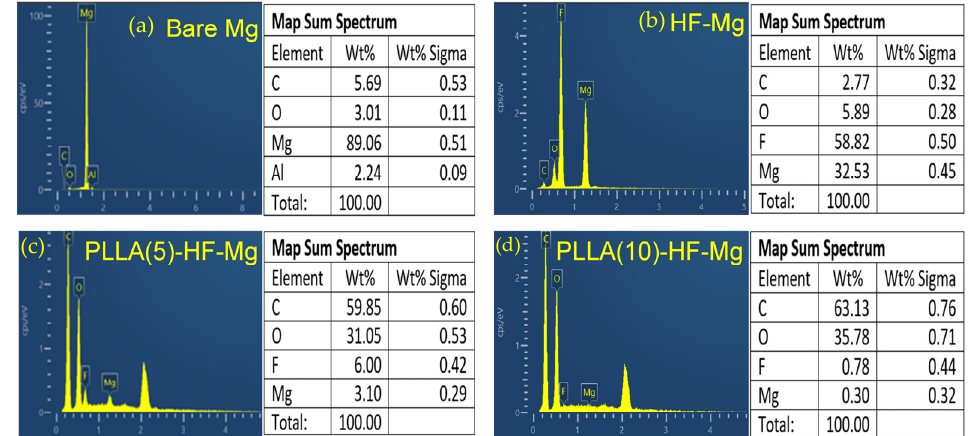
Figure 4. Elemental composition of the surface of ( a ) bare Mg alloy, ( b ) HF-Mg and ( c ) PLLA (5)-HF-Mg, ( d ) PLLA (10)-HF-Mg.